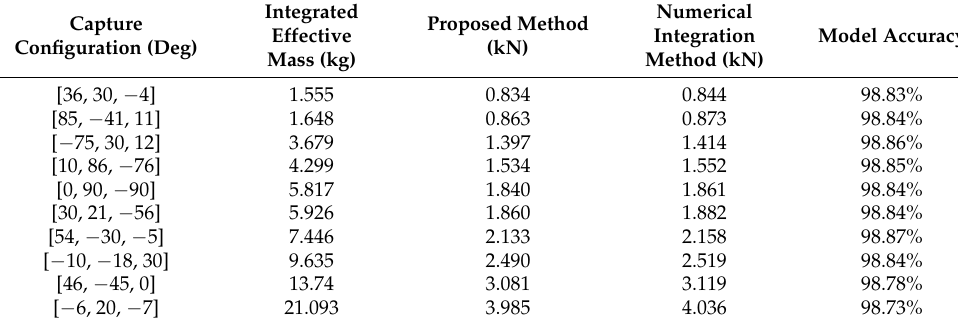
Table 3. Accuracy of maximum-contact-force model for 3-DOF space